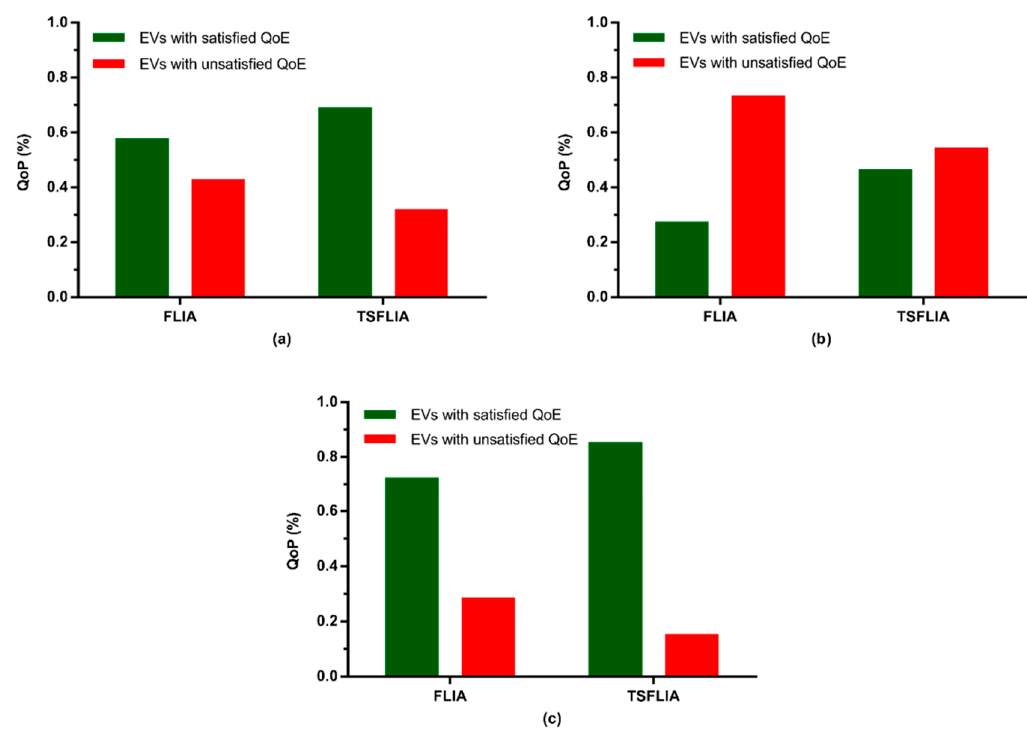
Figure 14. The QoP with respect to FLIA and TSFLIA for the PLs connected to the three buses: ( a ) Represents the PL connected to the bus #820; ( b ) Represents the PL connected to the bus #834; ( c ) Represents the PL connected to the bus